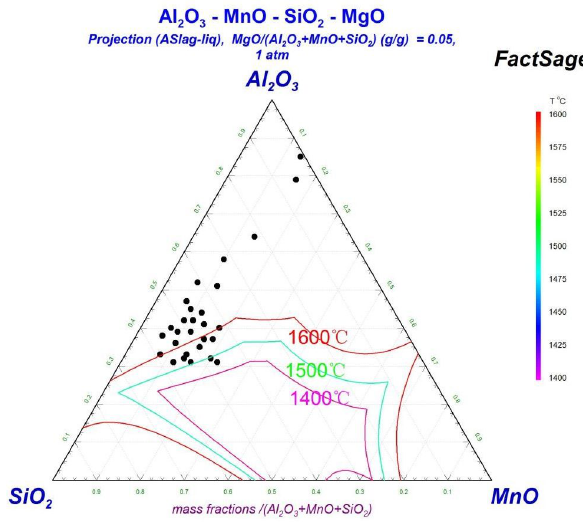
Figure 2: Composition distribution of inclusions in Al 2 O 3 -SiO 2 -MnO phase diagrams for S2